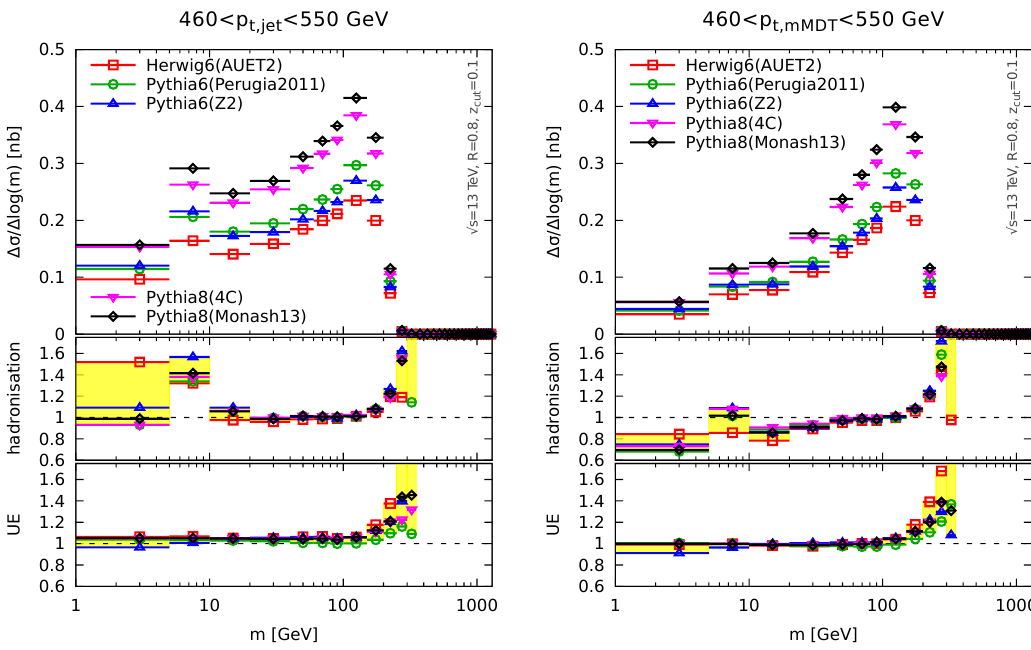
Figure 9 . The top plots show the groomed jet mass distribution for 460 < p t < 550 GeV, with hadronisation and the underlying event, for di(cid:11)erent Monte Carlo parton showers. The plot on the left is for the ungroomed p t; jet , while the one of the right for p t; mMDT . The bottom plots show the ratios hadron-to-parton level and with-to-without the underlying event.